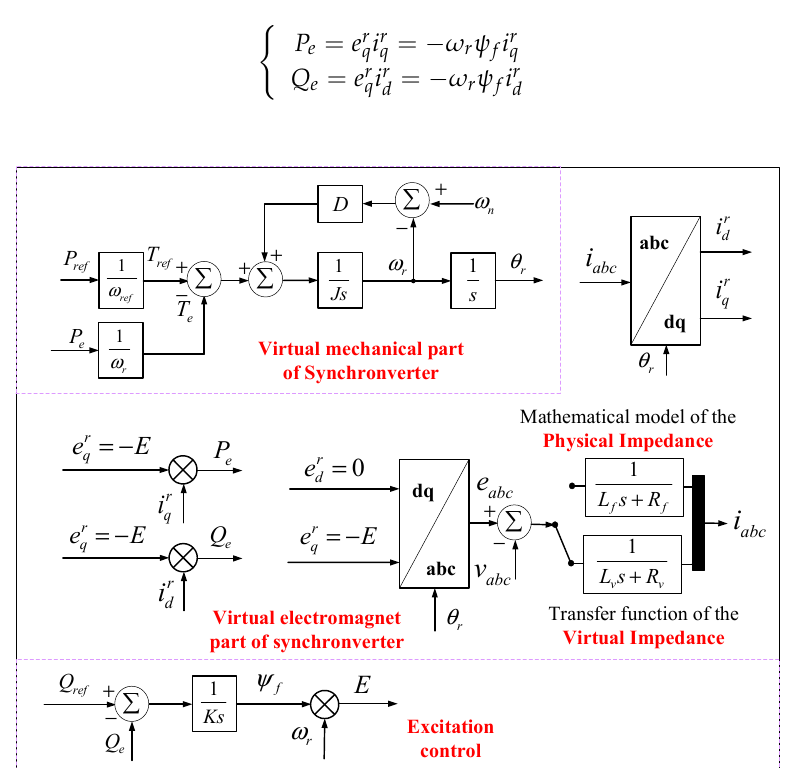
Figure 2. Control diagram of the conventional synchronverter.